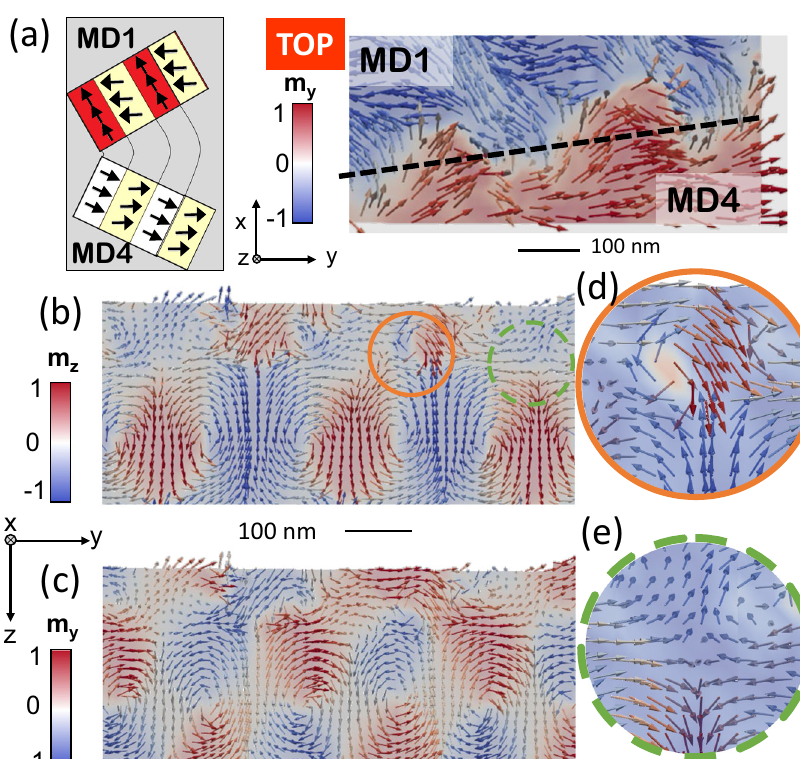
Fig. 7 Tomographic reconstruction of m(Gd) at the domain wall between MD1 and MD4. a Sketch of the boundary between MD1 and MD4 at a zig-zag corner of the stripe pattern and zoom view of magnetic tomogram at the ð x ; y ; 14nm Þ plane (Top Gd-Co layer) with m y contrast. ( b , c ) Vertical cross-section along domain wall (dashed line in ( a )) with m z and m y contrast, respectively. Note the antiparallel alignment of the magnetic moments at the exchange spring wall across the thickness both in m z and m y components and the symmetric con fi guration of closure domains. ( d , e ) Details of localized vortices (orange solid circle in ( b )) and antivortices (green dashed circle in ( b )) at the